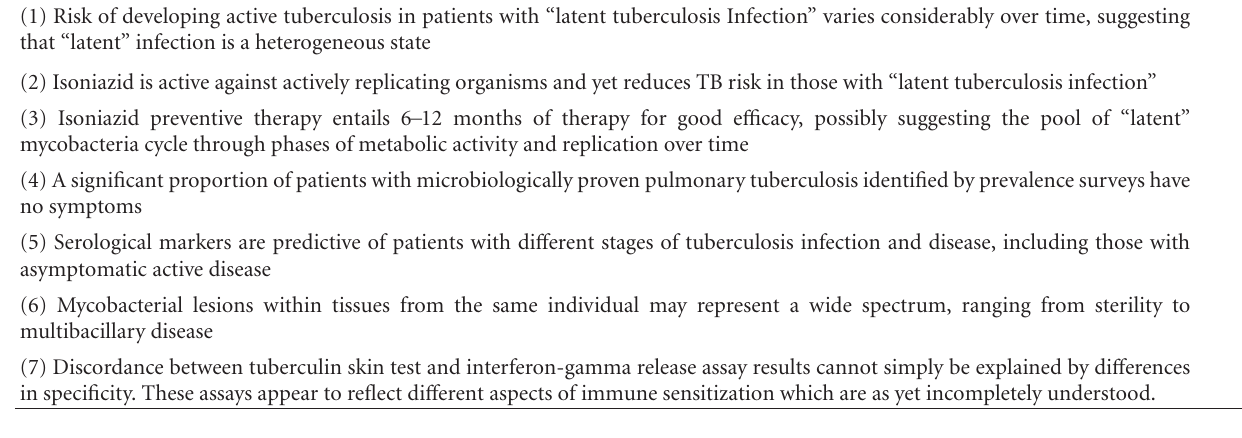
Table 1: Evidence that suggests the existing view of “latent tuberculosis infection” and active tuberculosis disease as binary compartmen- talised states is